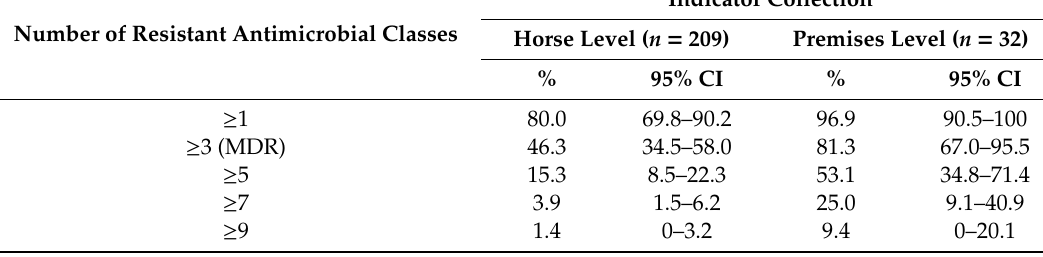
Table 1. Prevalence estimates (%) with 95% confidence intervals (95% CI) of healthy adult horses shedding E. coli isolates that are non-susceptible to more than 1, 3, 5, 7 or 9 classes of antimicrobials and premises housing these horses based on the indicator collection results in a cross-sectional study of 209 horses in 32 premises in Quebec in 2015 and 2016. Abbreviations: CI = confidence interval, MDR = multidrug-resistant.